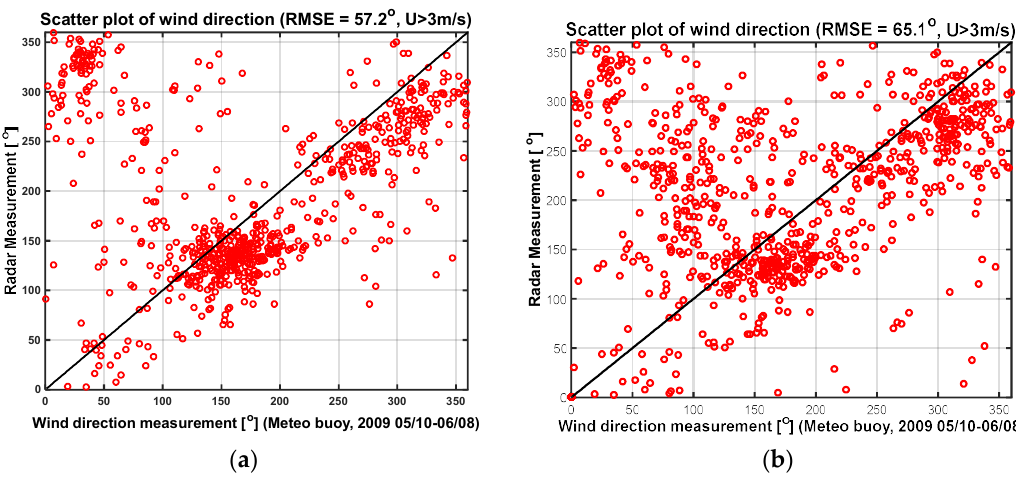
Figure 10. Comparison of wind direction measured by radar using the pattern-fitting method and